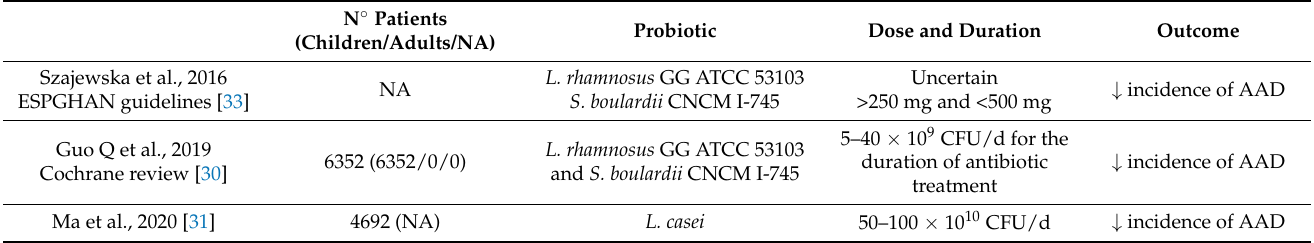
Table 3. Meta-analyses and systematic reviews on probiotics in antibiotic-associated diarrhea. N ◦